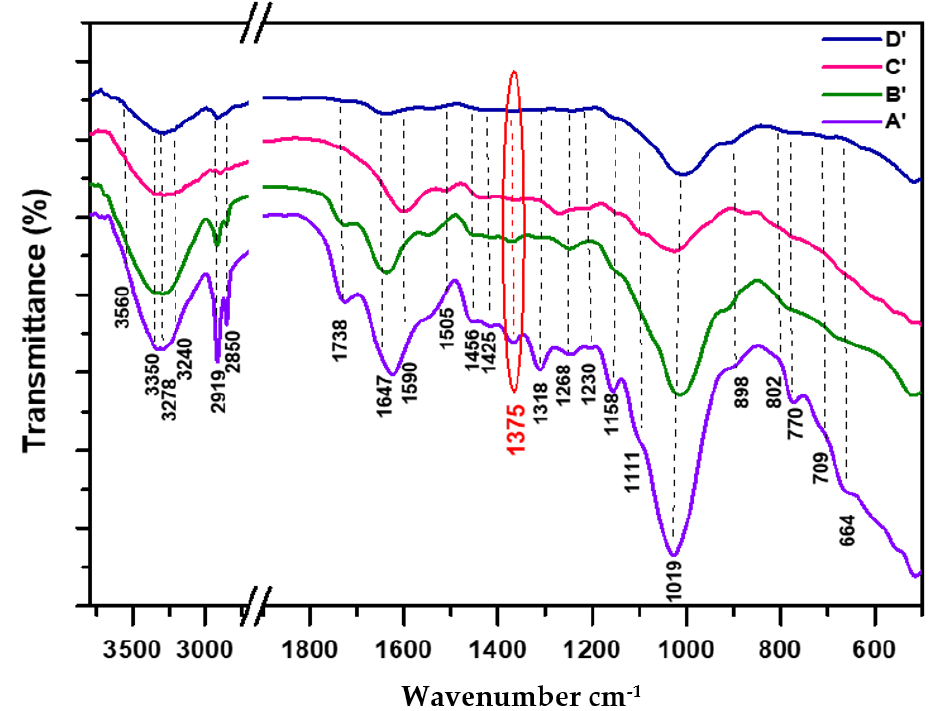
Figure 2. FTIR spectra of degraded cedar wood samples normalized at 1375 cm −1 : (A’: 21st century, B’: 19th century, C’: 17th century, D’: 16th century).